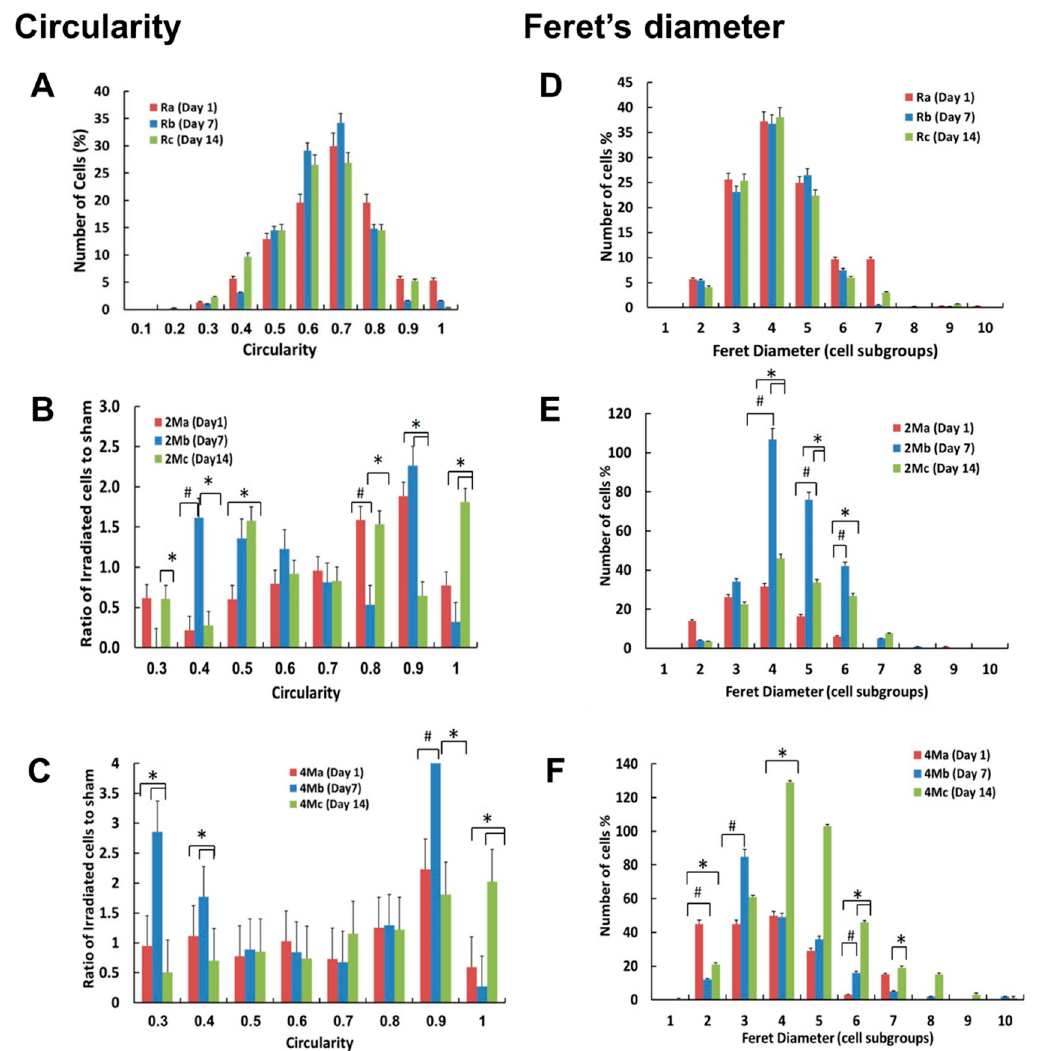
Figure 4. Distributions of cell circularity ( A – C ) and Feret’s diameter ( D – F ) following e ff ects of MMW irradiation; analyzed on Day 1 (red bars), Day 7 (blue bars) and Day 14 (green bars). Values of cell circularity were divided into 10 subgroups and the number of cells in each group counted. The Y-axis represents the ratios of the number of irradiated cells to the number of untreated control cells for the same subgroup. Cell circularity of H1299 cells left untreated ( A ); analyzed on day 1 (Ra), day 7 (Rb) and day 14 (Rc). Cell circularity of H1299 cells irradiated under 2 min exposure regime ( B ); analyzed on day 1 (2Ma), day 7 (2Mb) and day 14 (2Mc). Cell circularity of H1299 cells irradiated under the 4-min exposure regime ( C ); analyzed on day 1 (4Ma), day 7 (4Mb), and day 14 (4Mc). Values of Feret’s diameter were divided into 10 subgroups and the number of cells in each group counted. Each subgroup corresponds to 25 µ m for all experiments. The Y-axis represents the ratios of the number of irradiated cells to the number of untreated control cells for the same subgroup. Feret’s diameter of H1299 cells left untreated ( D ); analyzed on day 1 (Ra), day 7 (Rb), and day 14 (Rc). Feret’s diameter of H1299 cells irradiated under the 2-min exposure regime ( E ); analyzed on day 1 (2Ma), day 7 (2Mb), and day 14 (2Mc). Feret’s diameter of H1299 cells irradiated under the 4-min exposure regime ( F ); analyzed on day 1 (4Ma), day 7 (4Mb), and day 14 (4Mc). In total, 8000–10,000 cells were analyzed for every single experiment using Image J. Error bars represent the standard deviations of four biologically independent experiments (N = 4); p -values < 0.05 was considered statistically significant with * representing p < 0.05 (for a versus c or b versus c) and # representing p < 0.05 (for a versus b).